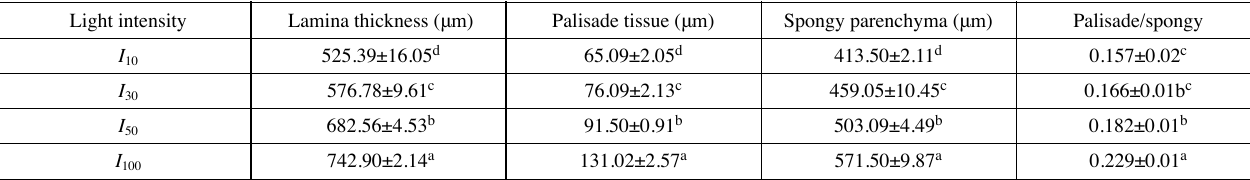
The values represent the mean ± SE, and the same letters indicated no significant differences in four shade treatment